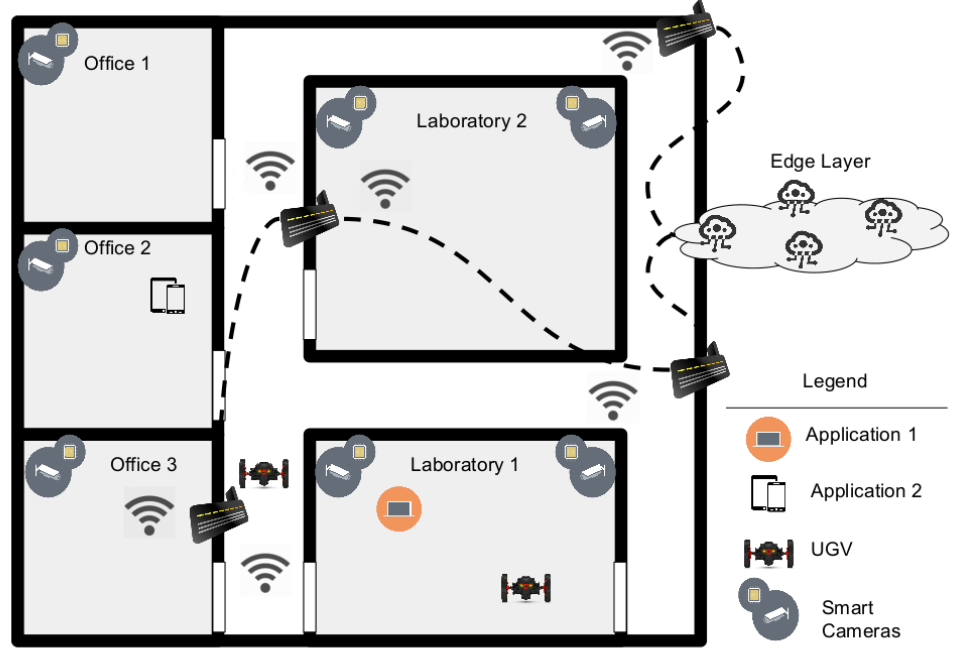
Figure 8. Test-bed configuration used for performing test campaigns in a controlled